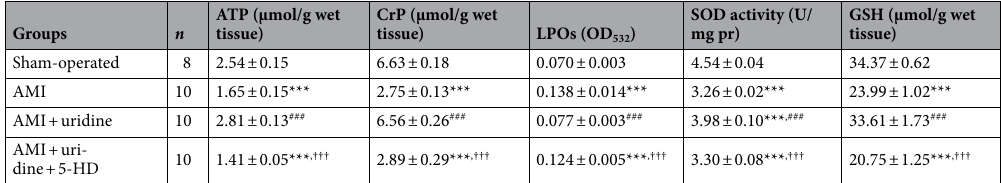
Table 2. Effect of uridine on the level of macroergic compounds, lipid peroxidation and antioxidant status in the rat myocardium in acute ischemia (60 min). AMI acute myocardial ischemia, 5-HD 5-hydroxydecanoate, CrP creatine phosphate, LPOs lipid hydroperoxides, SOD superoxide dismutase, GSH reduced glutathione. All data are mean ± SEM ( n = 8–10). *** p < 0.001 versus sham-operated group; ## p < 0.01 versus AMI group, ### p < 0.001 versus AMI group; ††† p < 0.001 versus AMI + uridine group. Significance of differences was determined by a one-way ANOVA followed by the Turkey’s multiple comparison Post Hoc test